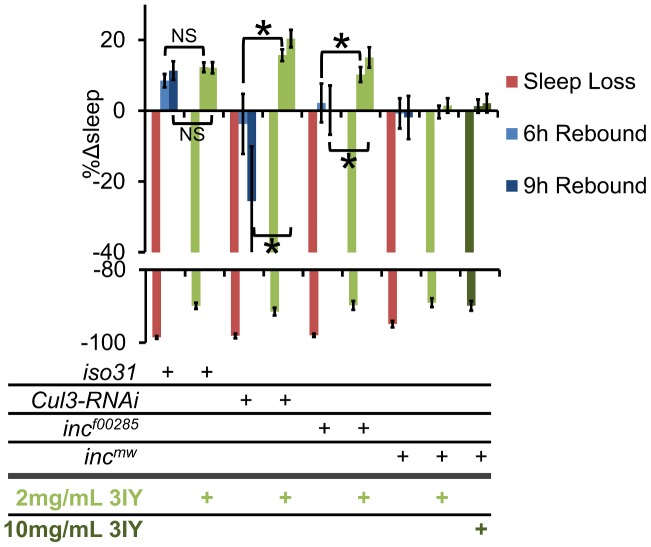
3IY rescues sleep homeostasis defects in Cul3-RNAi and incf00285 but not incmw.The graph shows the percent change in sleep (%Δsleep) after 12 h of mechanical sleep deprivation (red), 6 h of sleep recovery (light blue), and 9 h of sleep recovery (dark blue) in iso31, elav-Gal4;Cul3-RNAi/UAS-dcr2 (Cul3-RNAi), incf00285, and incmw with 2 mg/mL 3IY (light green), 10 mg/mL 3IY (dark green) or no 3IY. n≥41 females for all conditions. * p<0.05. Error bars are SEM.